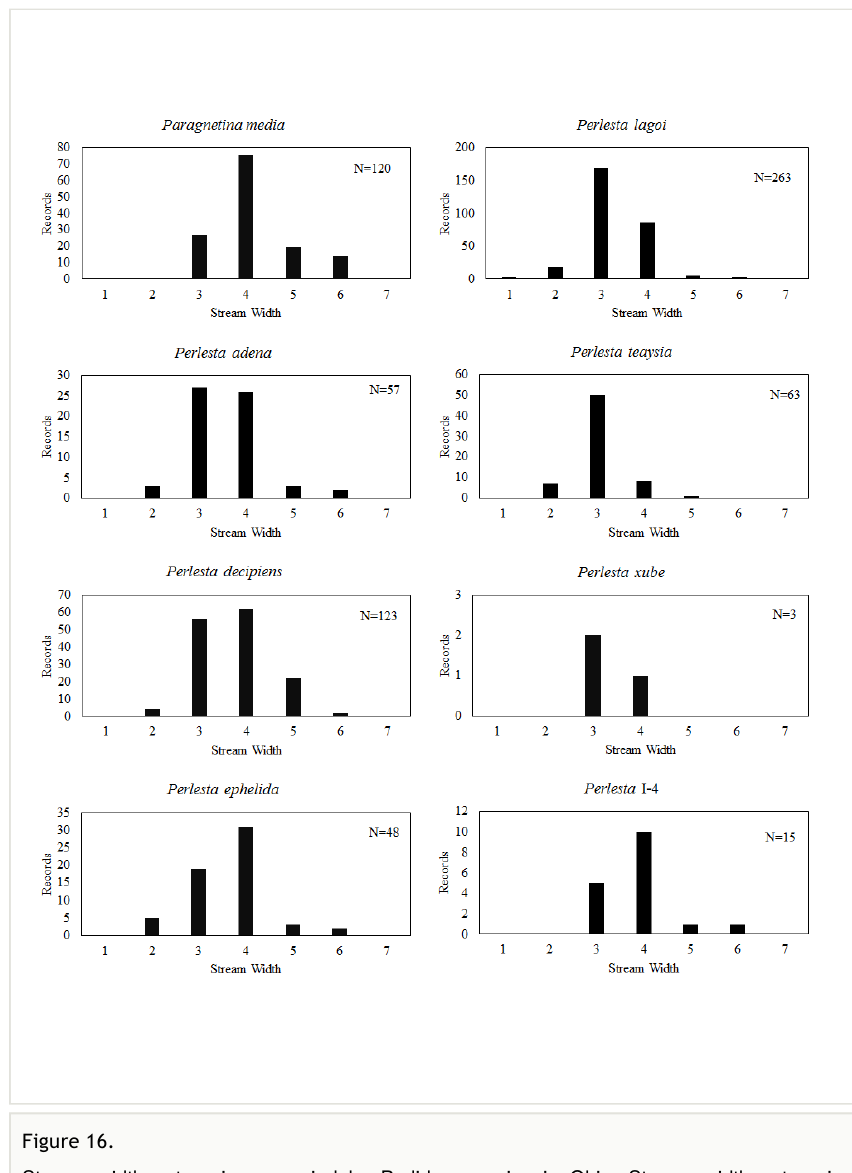
Stream width categories occupied by Perlidae species in Ohio.